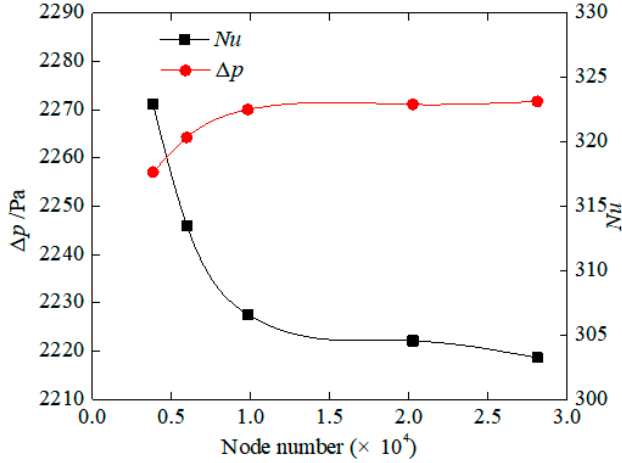
Figure 5. Grid independence check. The grid independence validation is carried out using the dimple hexahedral mesh. Table 1 gives comparison in average Nusselt number and pressure difference as well as its difference among four mesh sizes. It can be seen that Nusselt number and pressure difference change by 0.017% and 0.094% from gird size of 4682 to 28,320, respectively. Consequently, the mesh size of 20,488 is adopted for the simulation of case. Simultane- ously, the mesh sizes employed for other cases are ranging from 4682 to 28,320. Table 1. The effect of mesh sizes on the Nusselt number and pressure difference. Grid Number